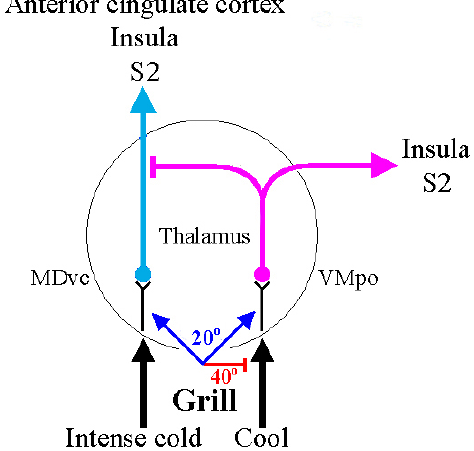
FIGURE 2 . A schematic representation of how the thermal grill might produce an illusion of pain and illustrates the pathways described by Craig[5] Cool stimuli excite the spinothalamic pathway through the VMpo (purple), which subsequently inhibits the pathway through the MDvc (turquoise). In the thermal grill experiment, both pathways are excited by the 20ºC stimulation (blue). The warm, 40ºC, bars (red), however, also inhibit the VMpo, but not the MDvc pathway, resulting in less excitation entering the inhibitory pathway. The net output is through the MDvc pathway to the anterior cingulate cortex resulting in the experience of a burning pain. Developed from